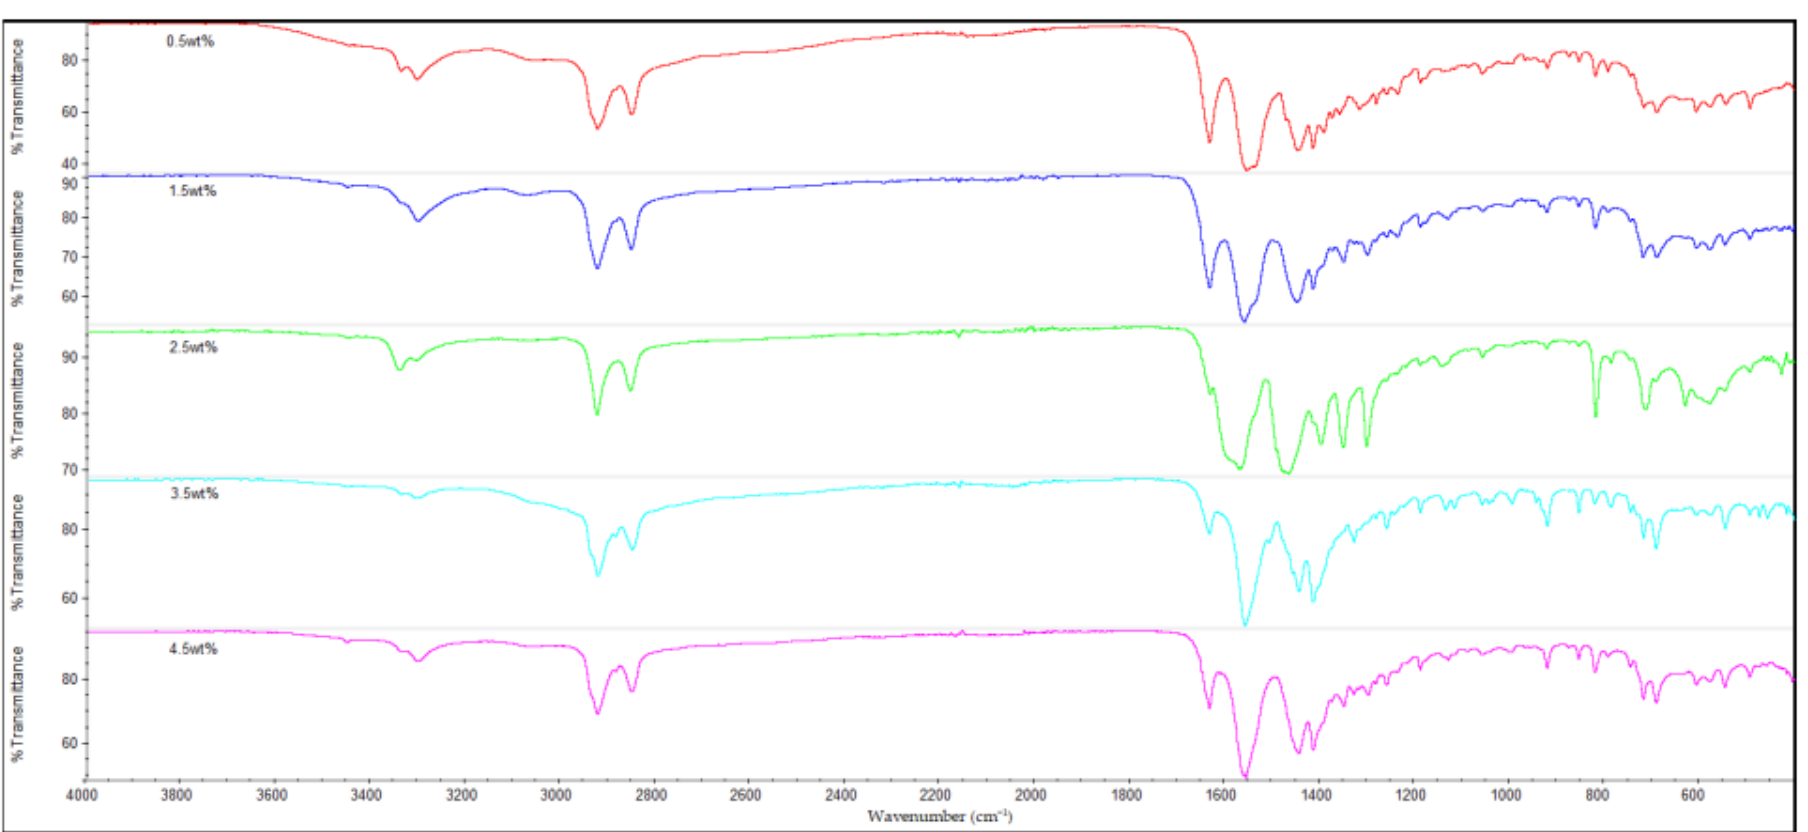
Figure 13. FTIR Spectra for Nylon 610 Nanocomposites with Untreated Graphite Flakes.